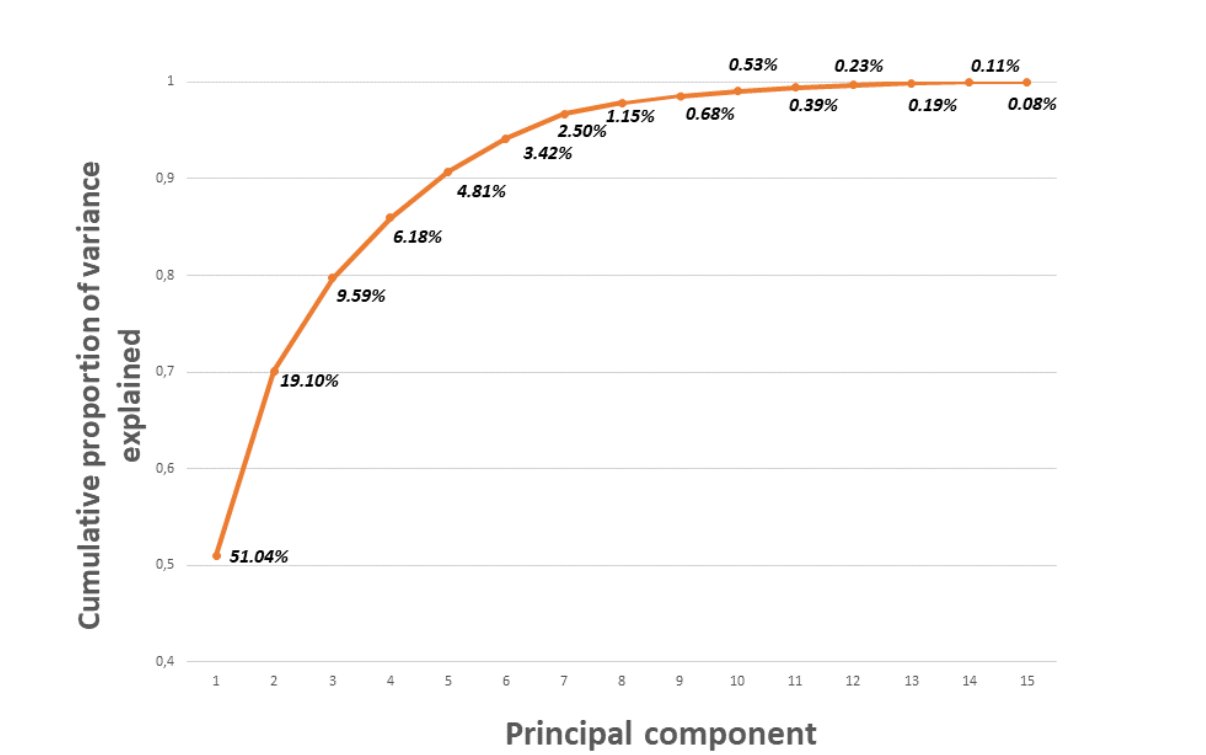
Figure 3. Cumulative percentage of the explained variance using principal component